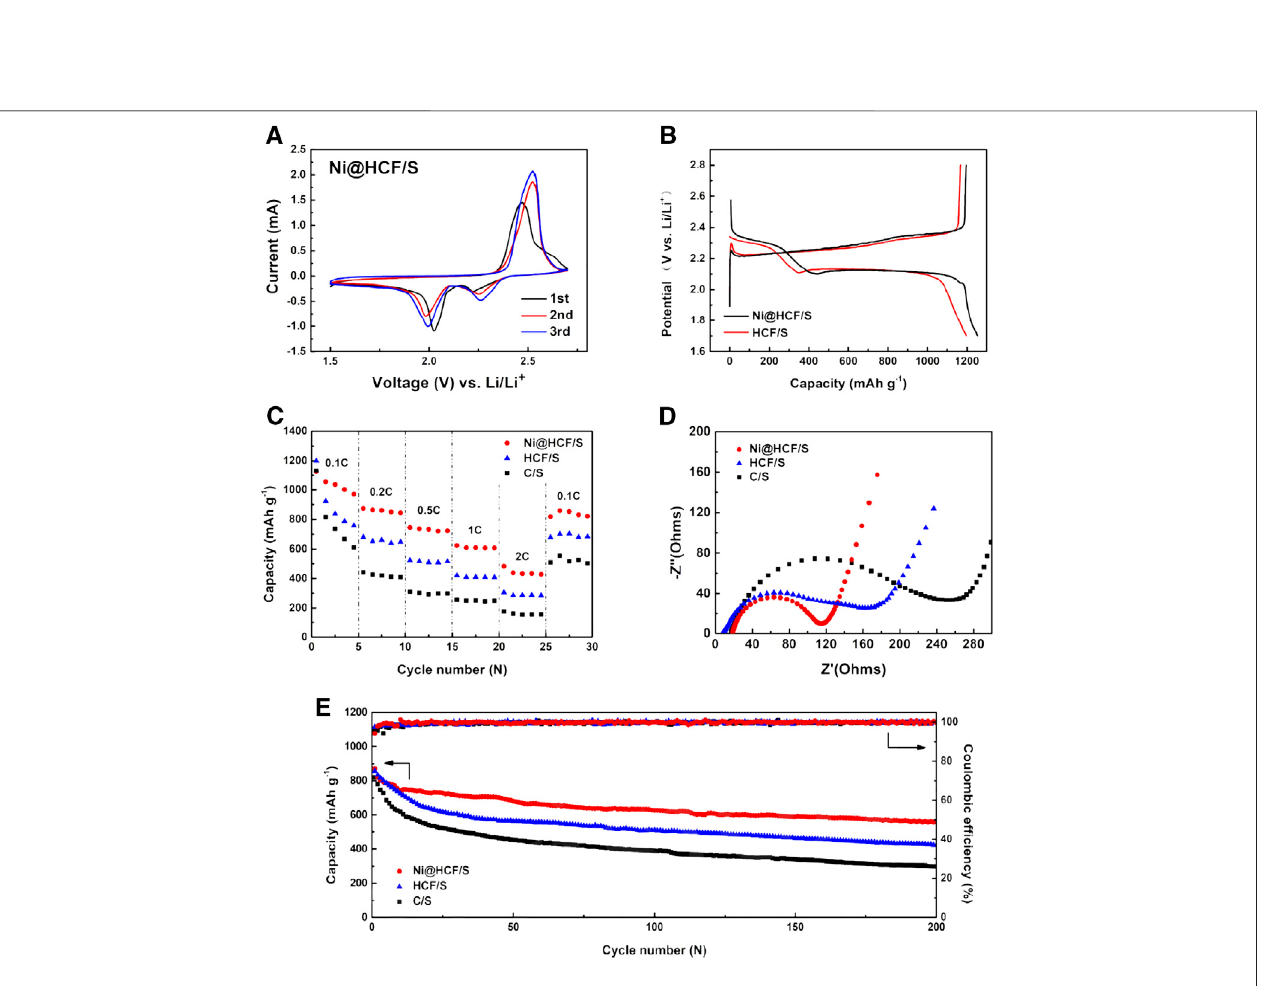
Frontiers in Energy Research |